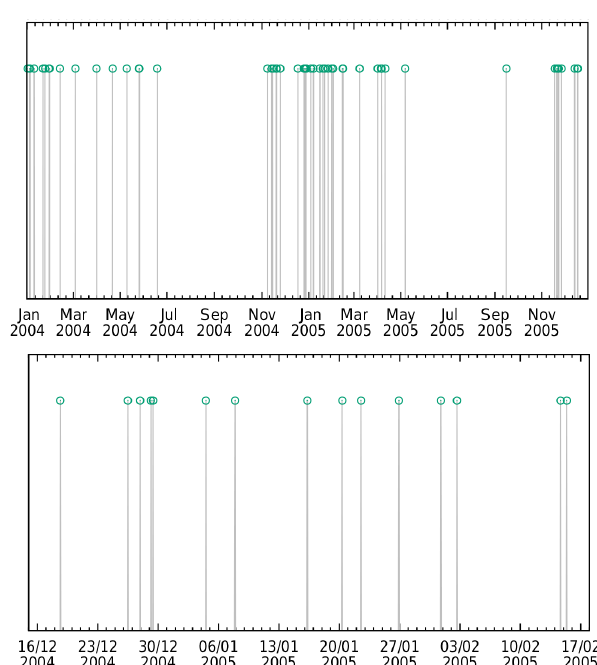
Figure 3. Storm occurrence for the northern Tyrrhenian reference point (A): 2004/2005 in the top panel, zoomed-in graph of win- ter 2004/2005 in the bottom panel.